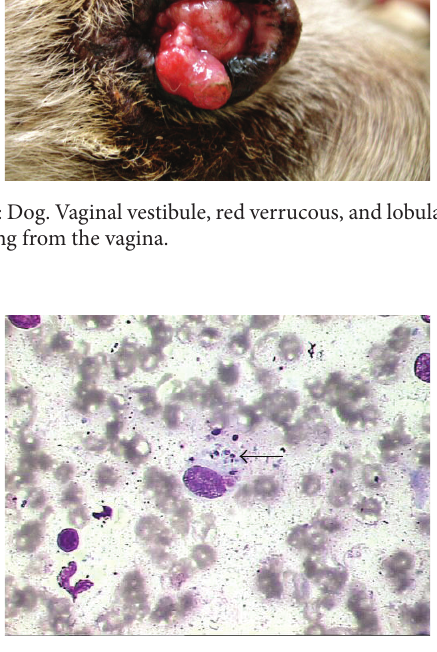
Figure 2: Dog. Photomicrograph of cytology imprint from the vaginal mass with a histiocyte-like cell with three intracytoplasmic protozoa amastigotes (arrow) (Diff-Quick, 100x).